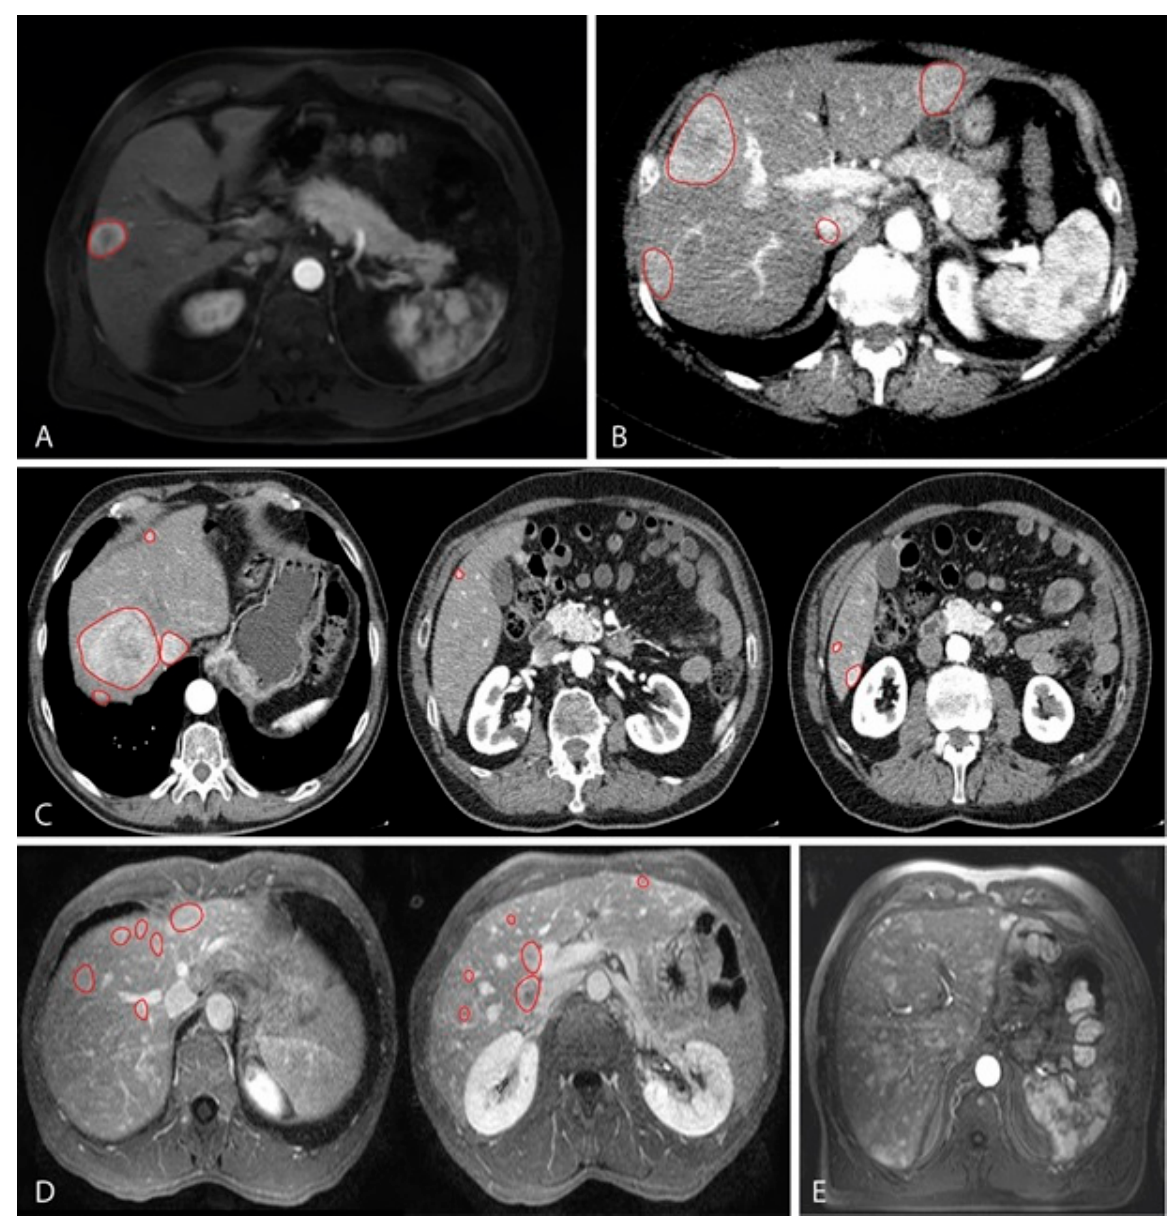
Figure 1. MRI images representing the classification based on the number of lesions found in metastatic UM in the liver, which have been contrasted by red markings; ( A ) T1 weighted MRI with contrast showing a single nodular lesion in the liver; ( B ) T2 weighted MRI with contrast showing four lesions; ( C ) T2 weighted MRI sequence with contrast showing a total of seven lesions. Images from left to right correspond, respectively, from cranial to caudal localization; ( D ) T2 weighted MRI sequence with contrast showing a total of 12 lesions. Images from left to right correspond, respectively, from cranial to caudal localization; ( E ) T2 weighted MRI with contrast showing innumerable widespread small lesions throughout all liver segments. No red markings are present due to the number of lesions.